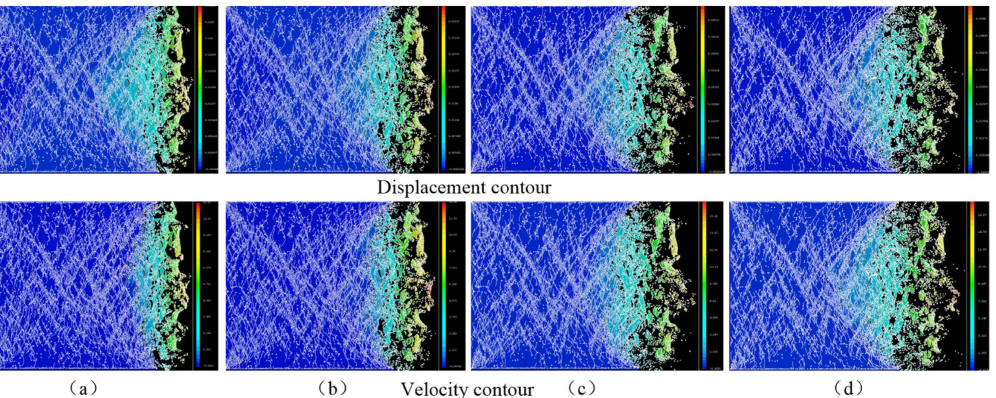
Figure 9. The crack distribution, displacement contour and velocity contour of numerical samples with different pore gas pressures: ( a ) 0.5 MPa gas pressure; ( b ) 1 MPa gas pressure; ( c ) 1.5 MPa gas pressure; and ( d ) 2 MPa gas